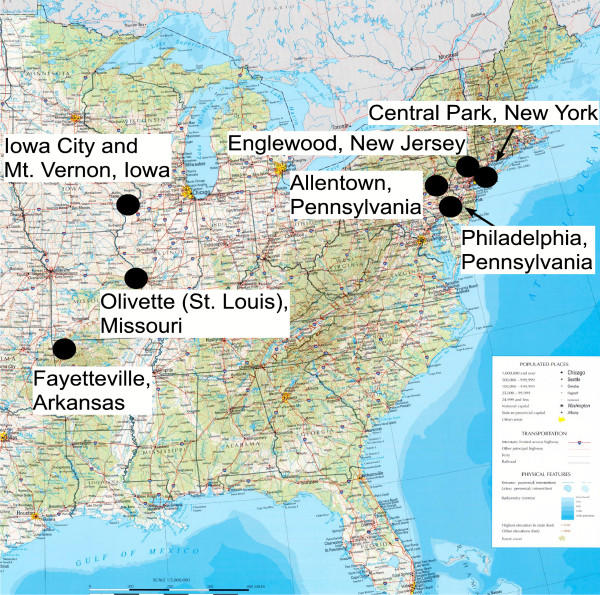
Map of the eastern United States showing the locations of collecting sites in this study. This modified map is used by permission of the University of Texas Libraries, the University of Texas at Austin.